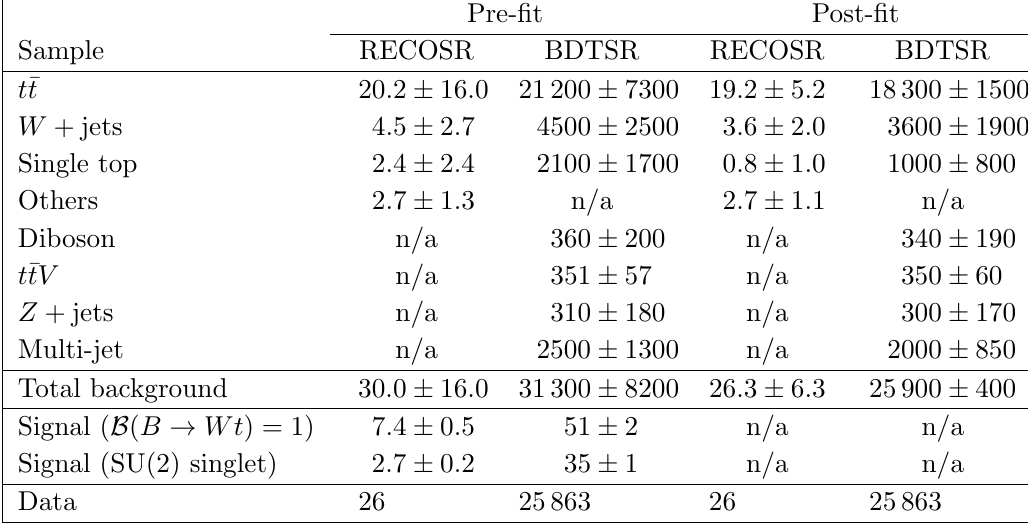
Table 2 . Event yields in the two signal regions before and after the background-only (cid:12)t (see 7.2). The quoted uncertainties include statistical and systematic uncertainties; for the t (cid:22) t background no cross-section uncertainty is included since it is a free parameter of the (cid:12)t. The contributions from dibosons, Z +jets, ttV and multi-jet production are included in the ‘Others’ category for the RECOSR, whereas they are counted separately within the BDTSR. Modelling errors on the small t (cid:22) tV background are neglected. In the post-(cid:12)t case, the uncertainties in the individual background components can be larger than the uncertainty in the sum of the backgrounds, which is constrained by data. Both signal models correspond to m B = 1300